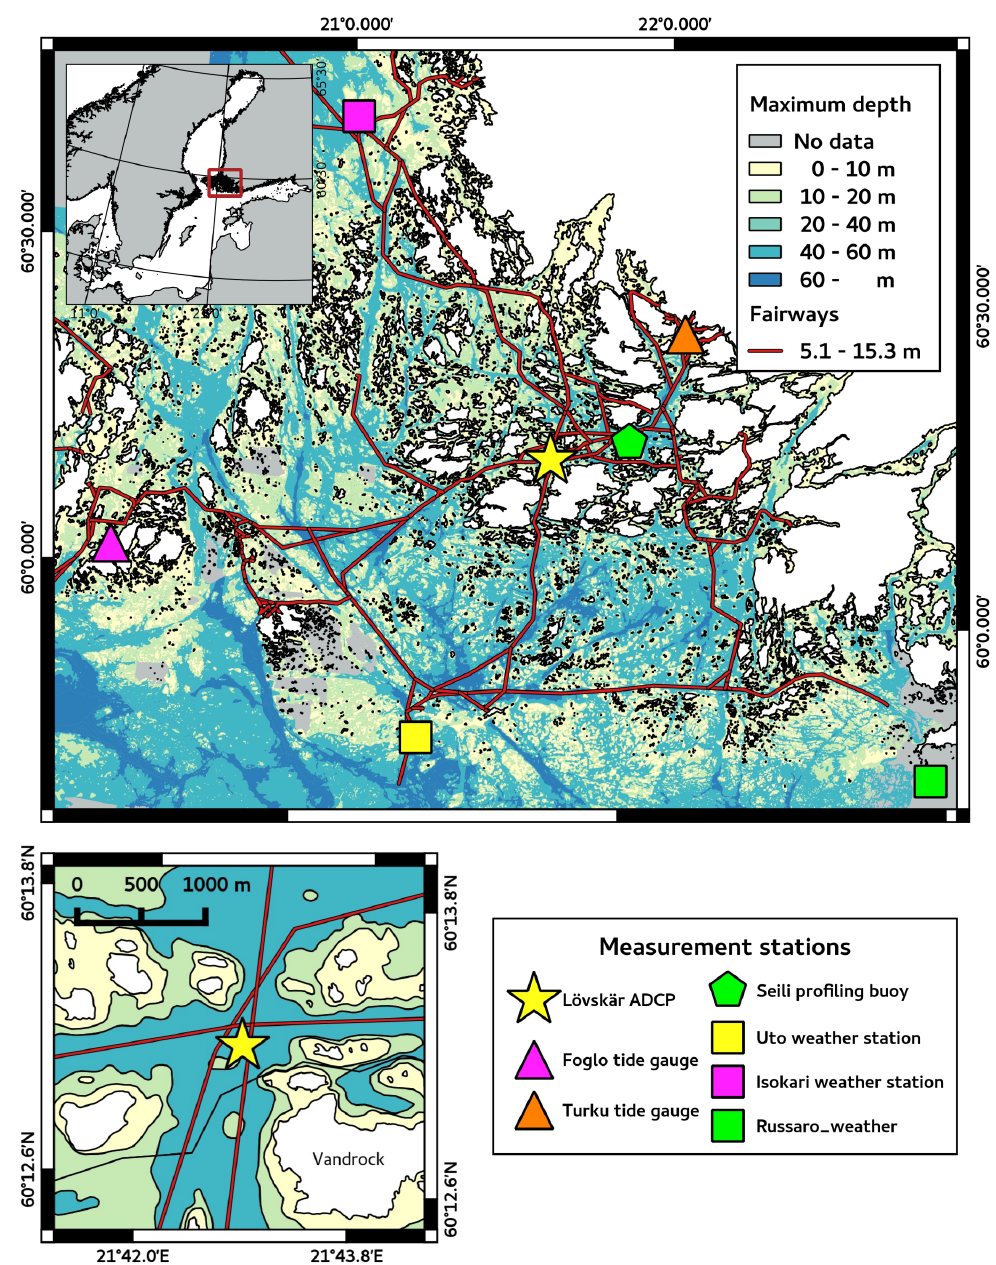
Figure 1. Map of the study area. The Lövskär cross section is presented in the lower left corner of the figure. Bathymetry and the locations of the fairways (deeper than 5 m) extracted from the Finnish Transport Agency’s open data base are shown. Areas in which bathymetric data were not available are presented with grey colour. The coast line is based on open-access data from the European Environment